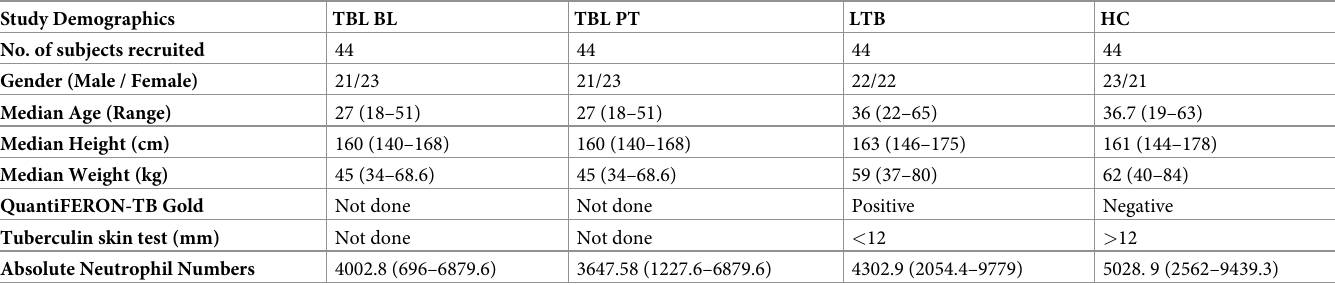
Table 1. Demographics of the study population.